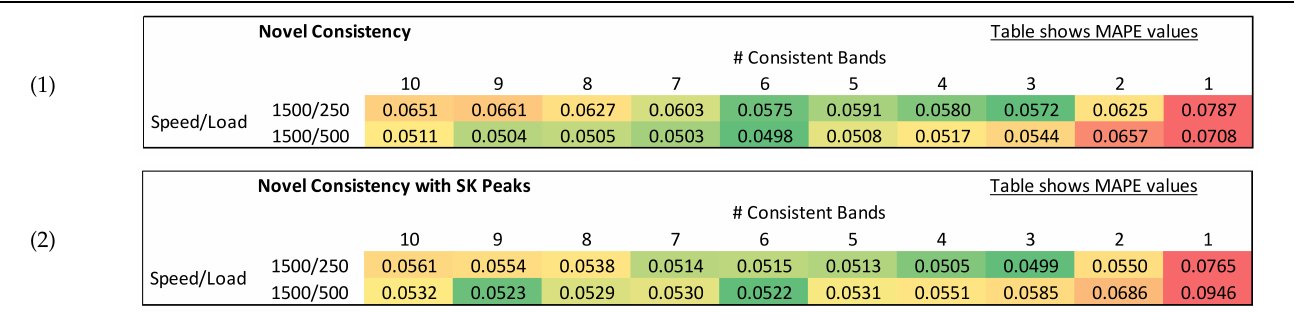
Table 1. Sensitivity analysis on length of input vector, i.e., how many consistent frequency bands to use; ( 1 ) Using novel consistency vector ( 2 ) Using novel consistency vector incorporating SK peak values. The colours represent the relative performance of each result, on a sliding scale from dark green (best outcome), through light green, yellow and orange, all the way to dark red (worst outcome) for each combination of operating